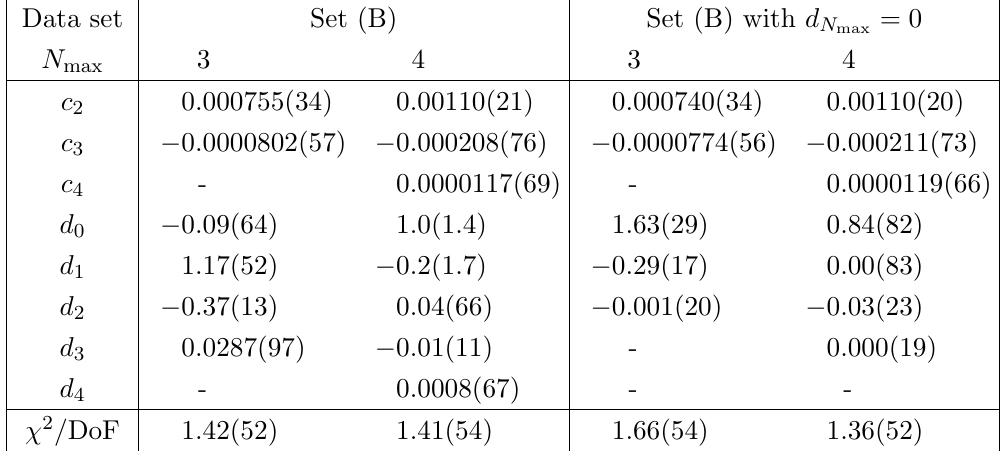
Table 3 . Fit results with the set (B) for the discrete beta function.